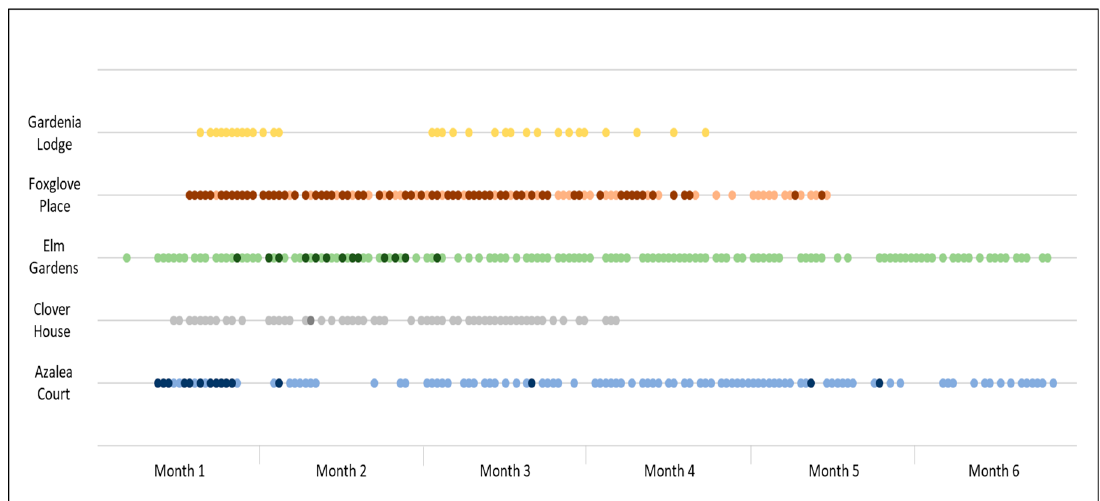
Figure 1. Frequency of NCI-UK sessions by care homes across implementation period (bold indicates 2 sessions in a day).